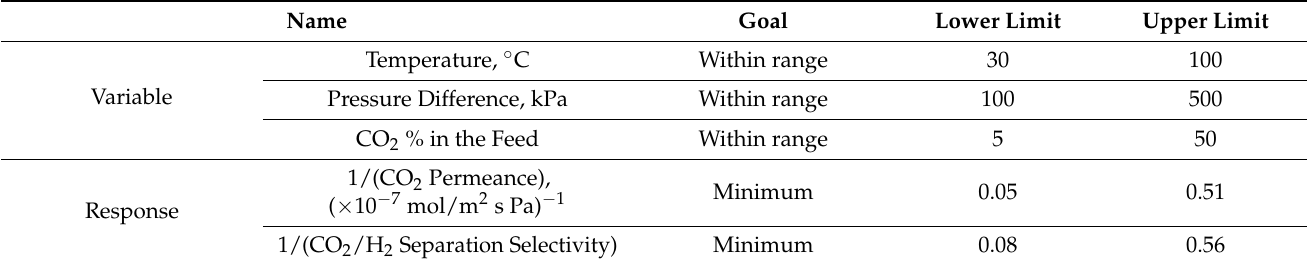
Table 5. Goal set for optimization of the studies of CO 2 /H 2 separation.